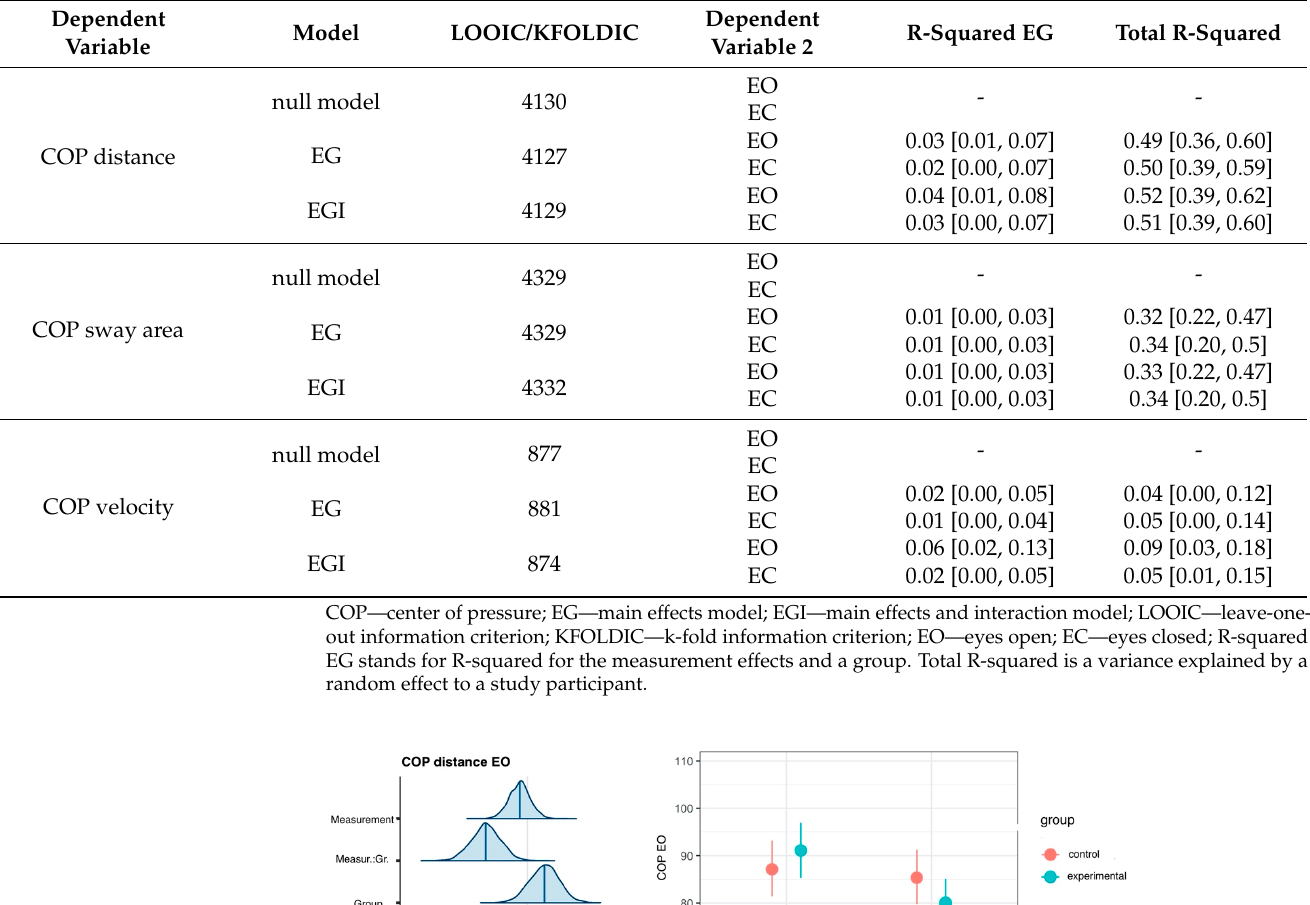
Table 2. Fitness of the regression models to the dataset used in this paper for testing differences between groups.